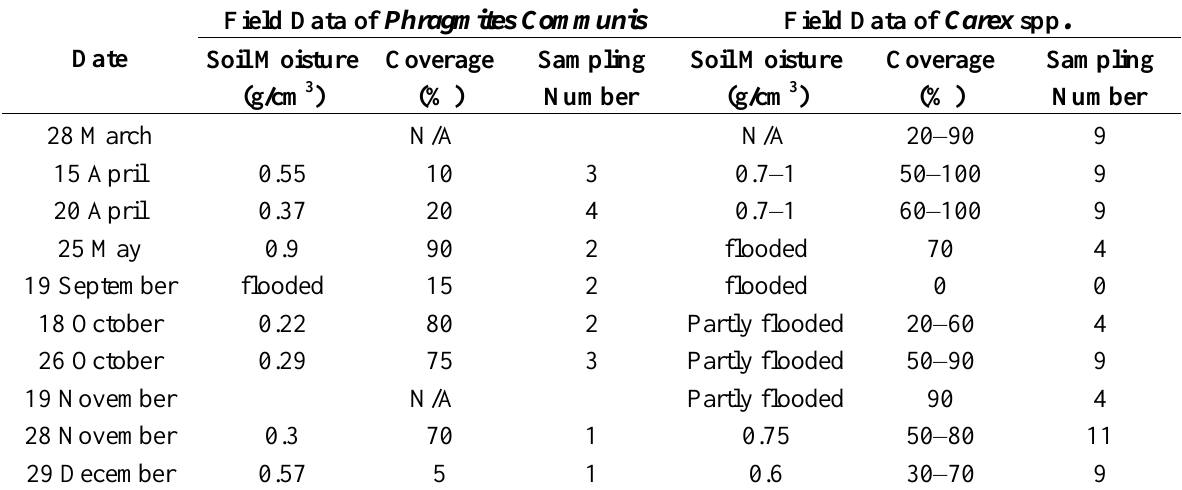
Table 1. Field measurements of wetland vegetation species in the study area in